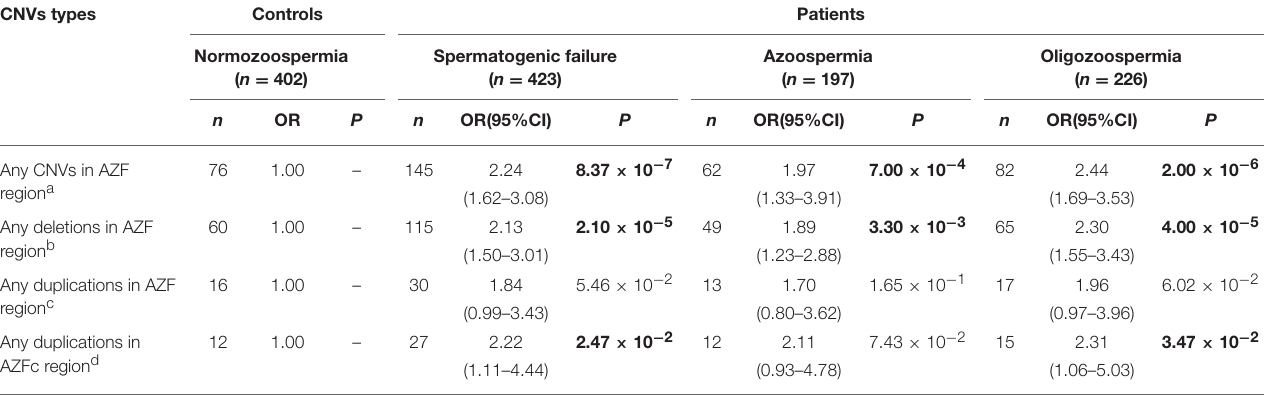
TABLE 5 | Comprehensive analysis of all AZF-linked CNVs and their effect on SF. CNVs